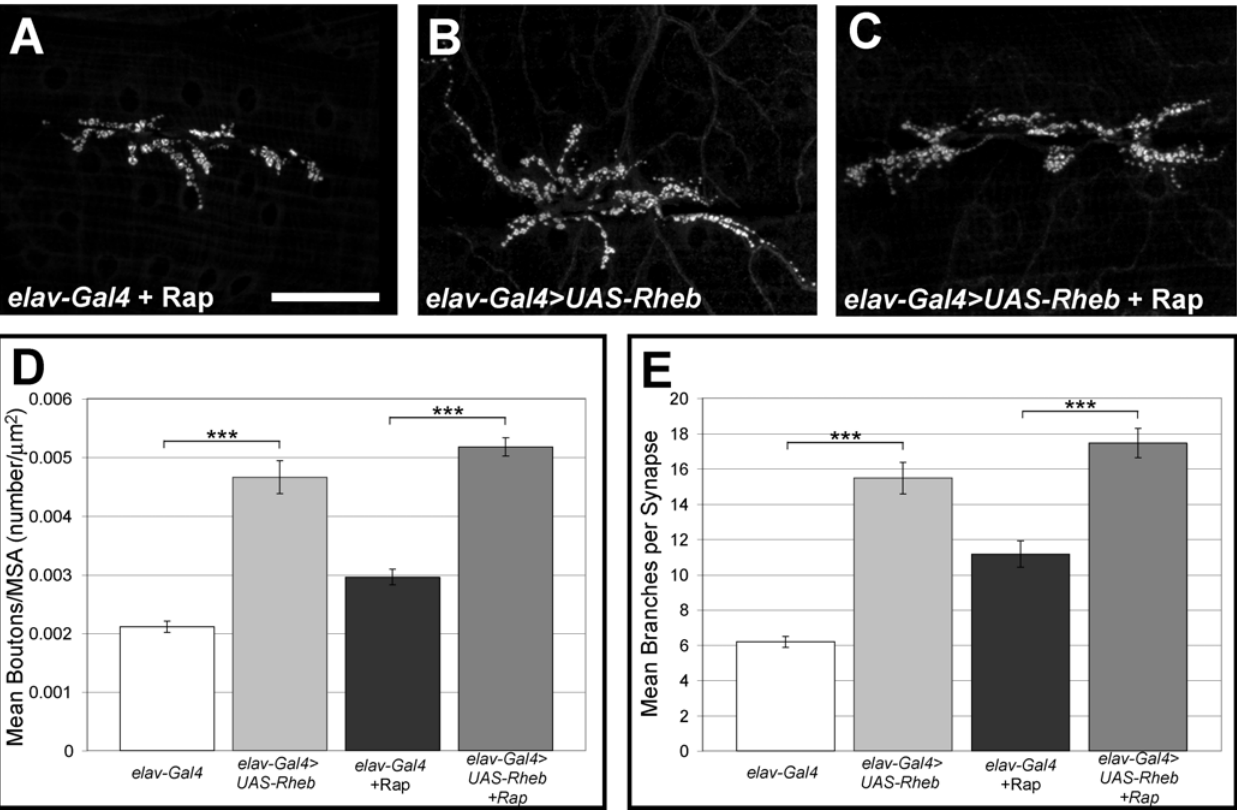
Figure 3. Rapamycin does not block Rheb-mediated synapse growth. Panels A–C show anti-CSP staining of NMJ synaptic boutons, demonstrating that the TORC1 inhibitor rapamycin does not block synapse growth in control animals or in larvae with neuron-directed expression of Rheb ( elav- Gal4 . UAS-Rheb ). Panels D and E provide quantification of bouton numbers/muscle area and numbers of motoneuron branches, respectively, for elav-gal4 controls (n=44), animals with neuronal expression of Rheb (n=41), control animals treated with rapamycin (n=26), and Rheb expressing animals treated with rapamycin (n=29). The scale bar is 50 microns.